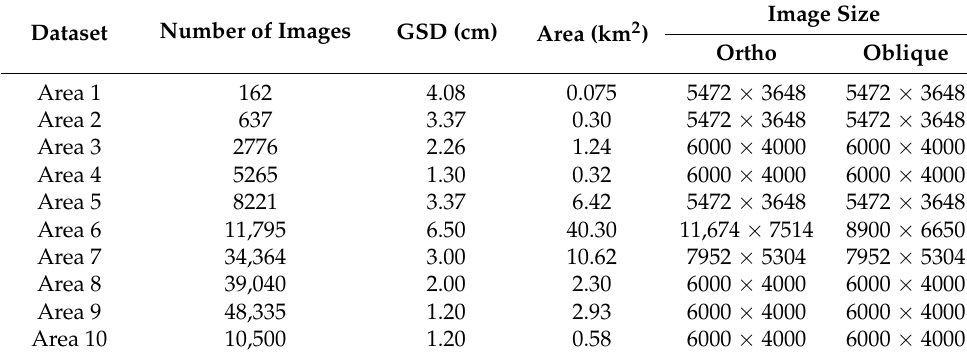
Table 2. Aerial oblique photographic dataset information.